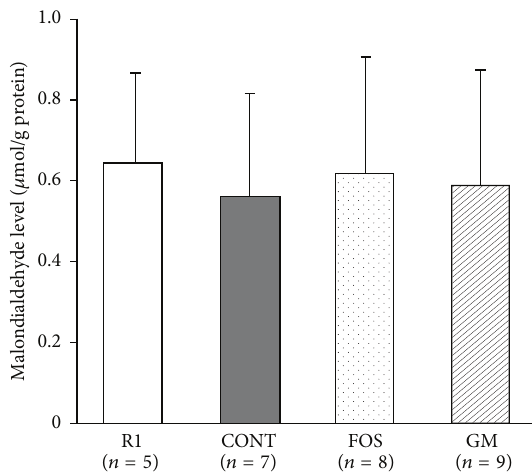
Figure 6: Effect of FOS orGM feeding on cerebral malondialdehyde at 38 weeks after feeding. Values were expressed as mean ± SD. R1, SAMR1, and control diet; CONT, control diet; FOS, 5% of fructooligosaccharide diet; GM, 5% of glucomannan diet. There was no significant difference among SAMR1 and SAMP8 groups by